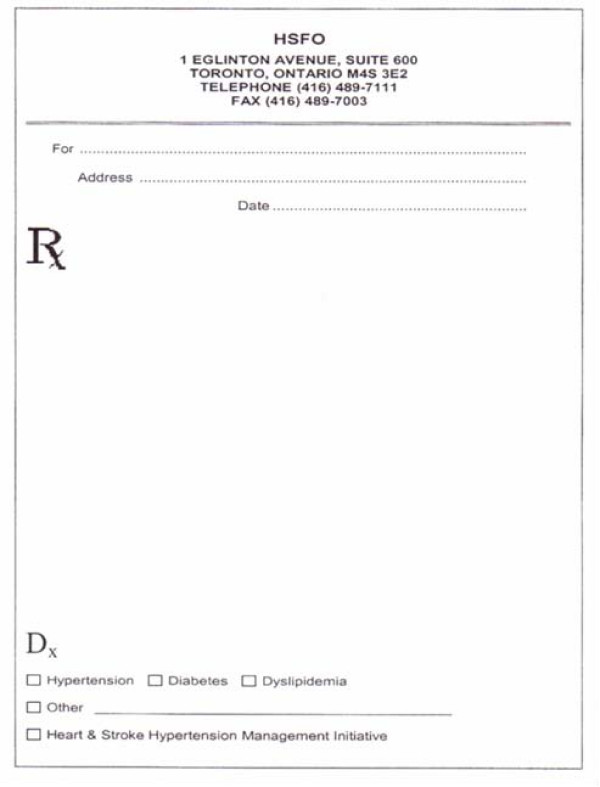
Rx Dx Prescription.